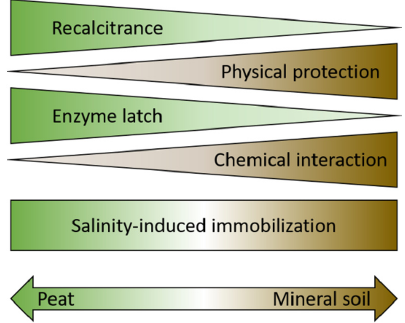
Figure 1. Proposed mechanisms underlying soil C stabilization in mangrove forests. Physical protection of soil C takes place through its occlusion within aggregates and / or small pores, while chemical interaction refers to interactions of organic matter with soil minerals and / or metals. Relative importance of each mechanism along the spectrum of the two types of mangrove soils is depicted schematically by the widths of the diagrams. Each mechanism is neither mutually exclusive nor strictly applied to only mineral or peaty mangrove soil, and overall stabilization of soil C pool is determined by combinations of these mechanisms plus environmental